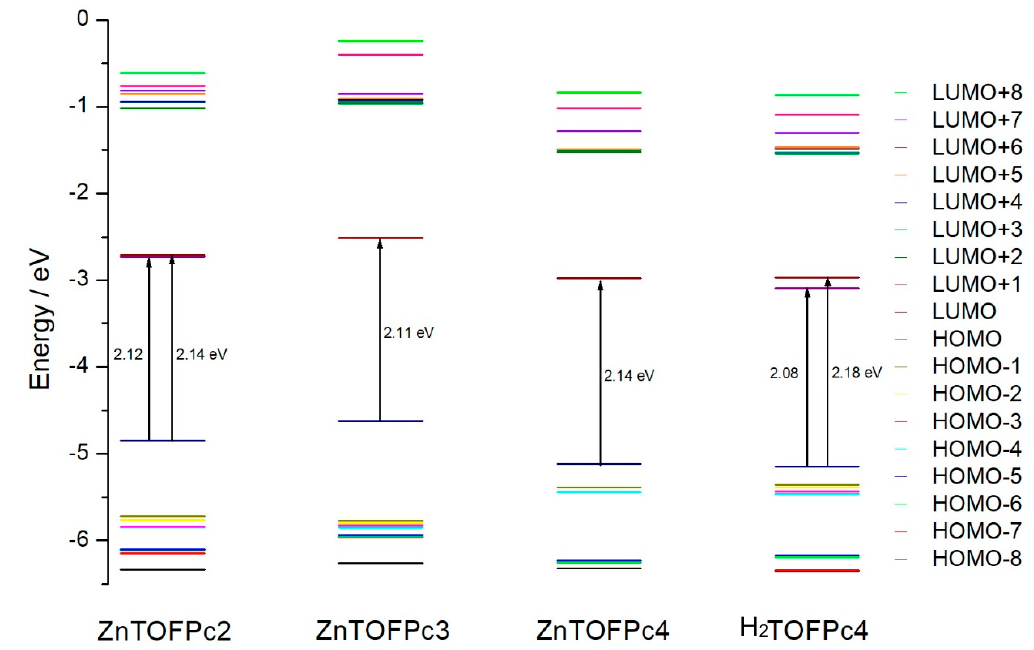
Figure 11. Frontier molecular energy levels (eV) of ZnTOFPc2 , ZnTOFPc3 , ZnTOFPc4 , and H 2 TOFPc4 obtained by time-dependent density functional theory (TD-DFT) B3LYP / 6–31* (H, C, N, O) / LANL2DZ (zinc). Only the energy gaps between the HOMO and the LUMO and LUMO + 1 levels are indicated.